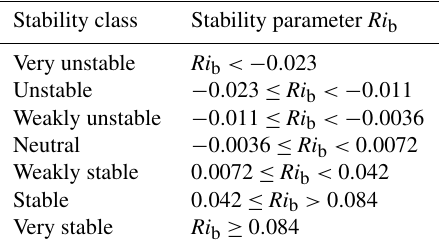
Table 1. Classification of atmospheric stability adapted from Sorb- jan and Grachev (2010).